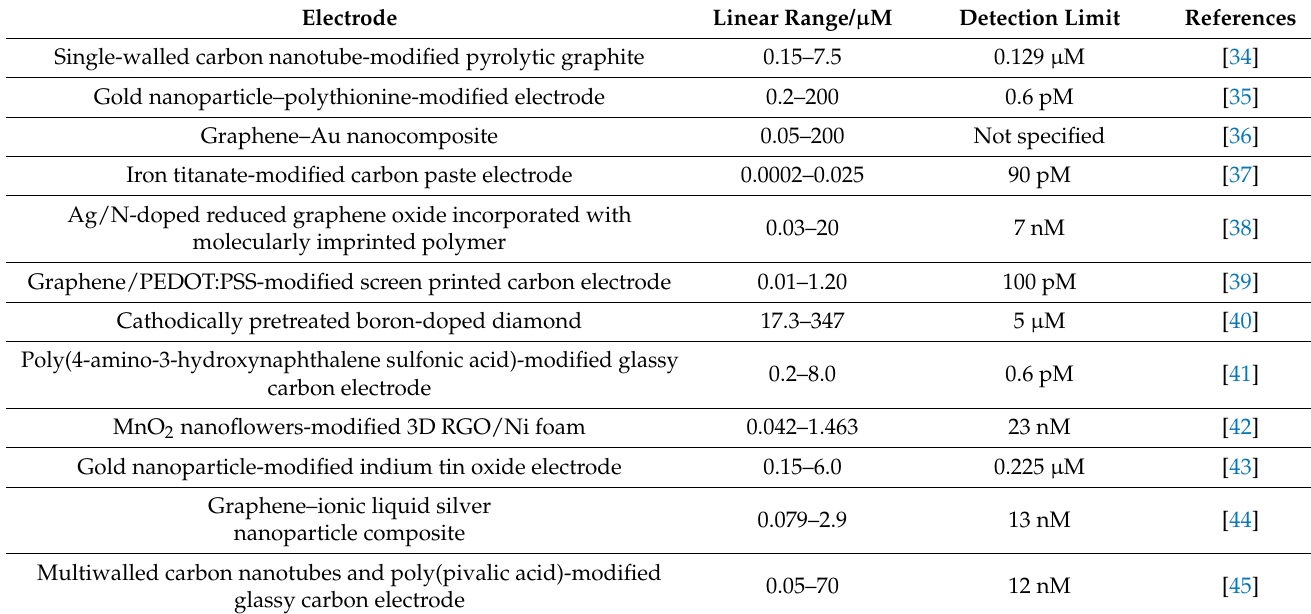
Table 1. This table gives an overview of electrochemical sensors applied to the voltammetric detection of salbutamol.